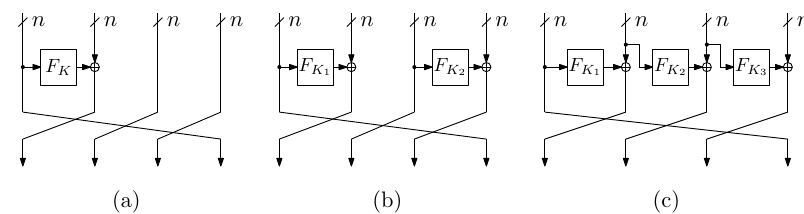
Figure 1: Round functions of classical PRF-based GFSs. (a) Type-1 (b) Type-2 (c) Type-3